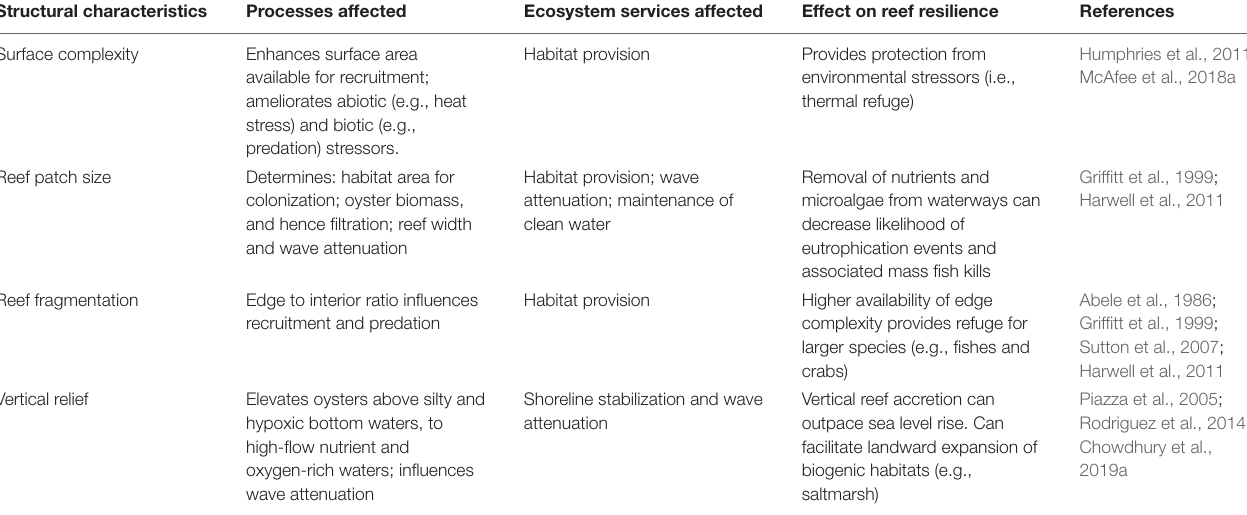
TABLE 1 | Key structural attributes of substrates that should be considered in oyster reef restoration, and their influences on ecosystem